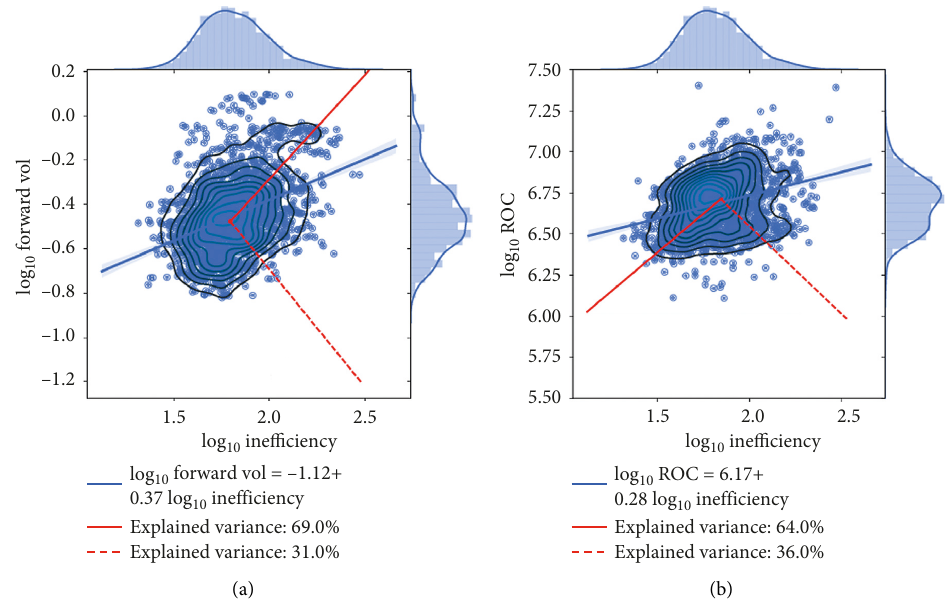
Figure 9: Regression results for log I vs. log forward volatility (a) and log I vs. log realized opportunity cost (ROC) (b). The solid red line shows 1 1 the first principal component, the dashed red line shows the second principal component, and the black lines are density contours of the data. The fit line is shown in blue, and its equation is shown in the legend. These panels highlight the strong correlation between I , forward volatility, and 1